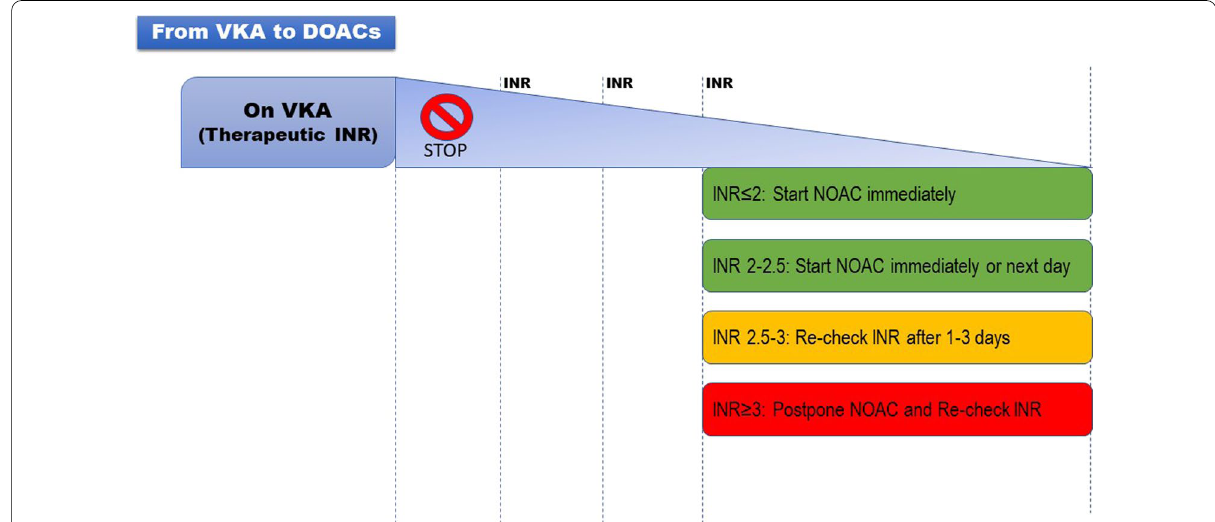
Fig. 2 Switching from VKA to